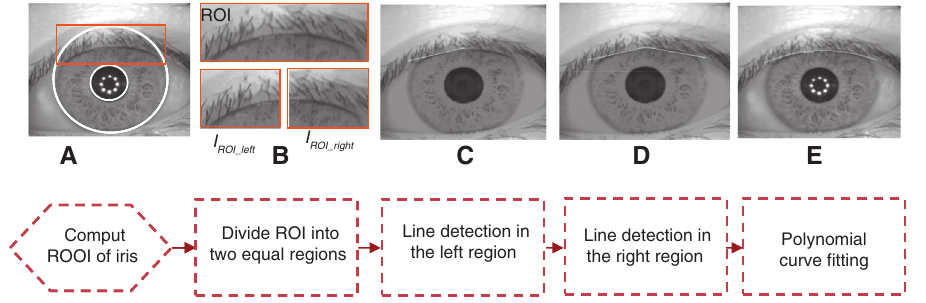
Figure 10. Flowchart of Top Eyelid Localization.